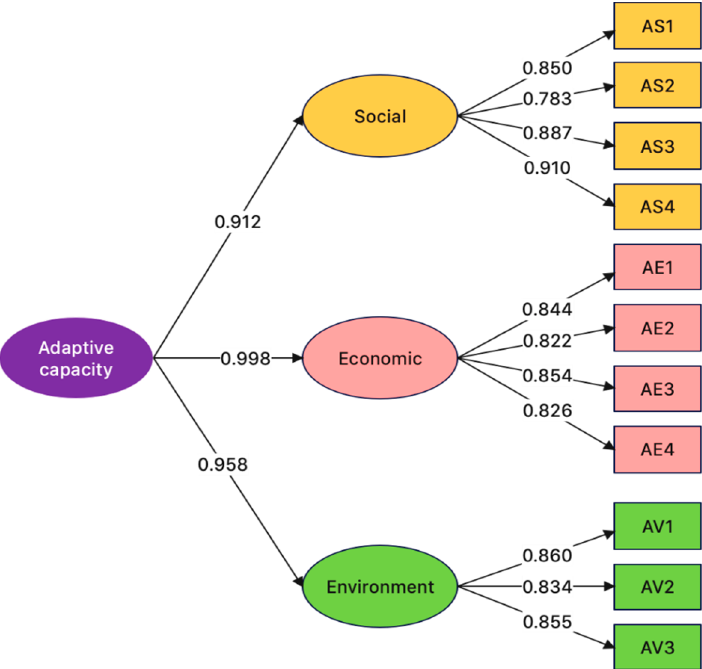
Figure 5. Structural equation model and the factor loadings of UHI adaptive capacity indicators and dimensions. Table 8. First- and second-order CFA of UHI adaptive capacity